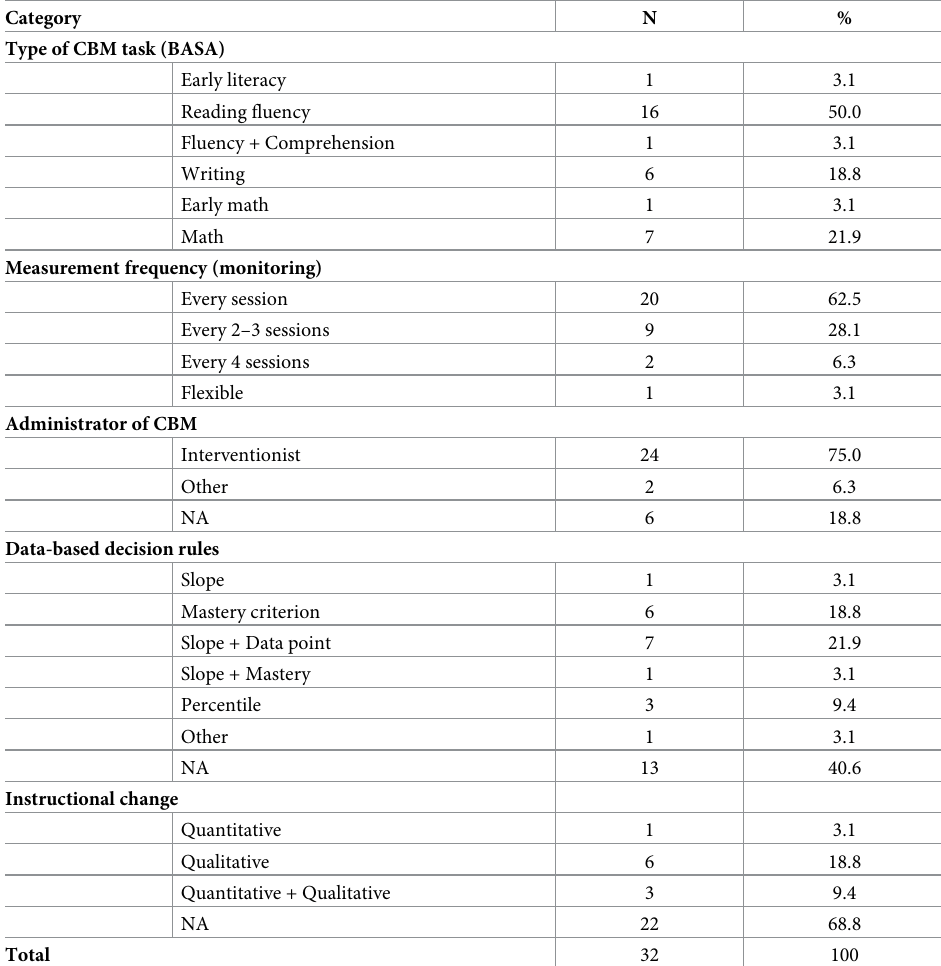
Table 6. DBI-related characteristics of the